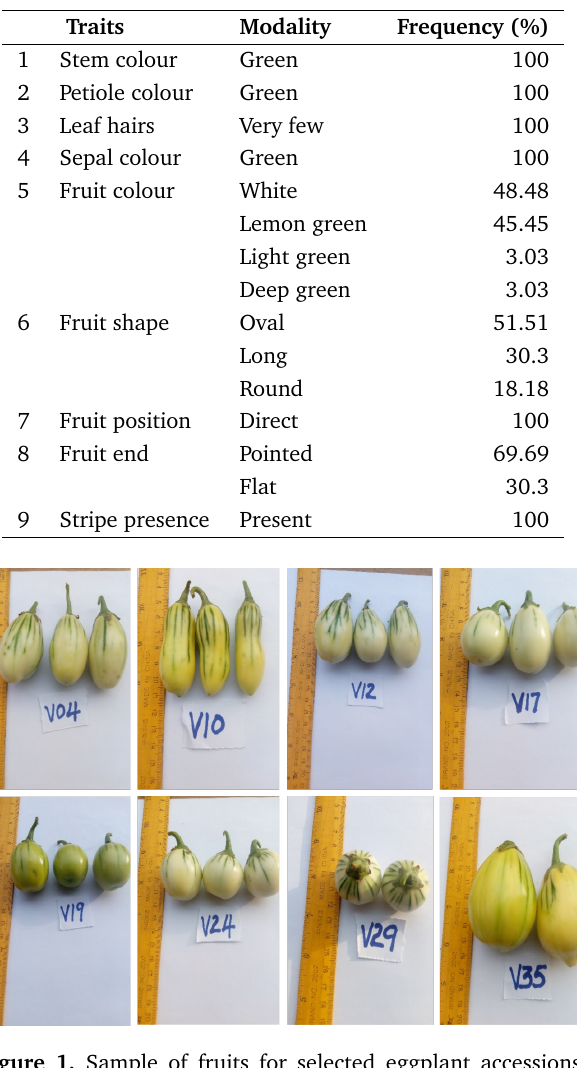
Table 2. Qualitative traits of 20 Solanum aethiopicum